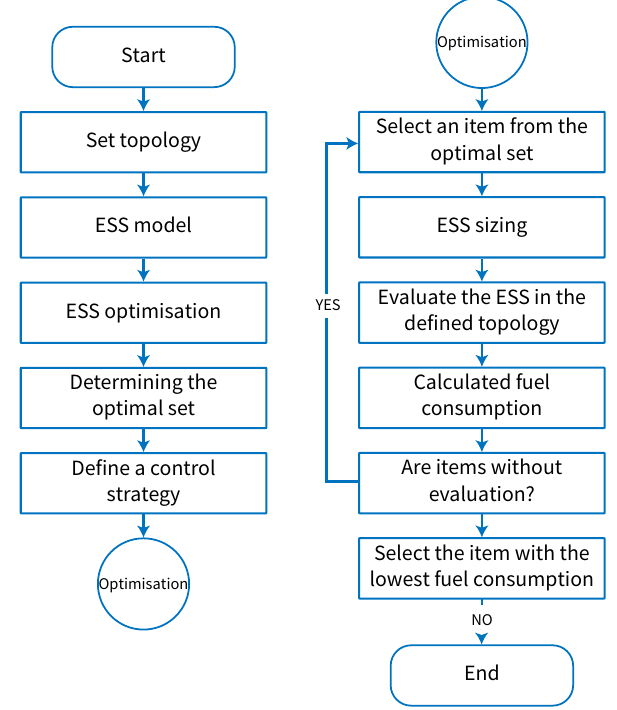
Figure 2. Methodology for optimal sizing of the energy storage